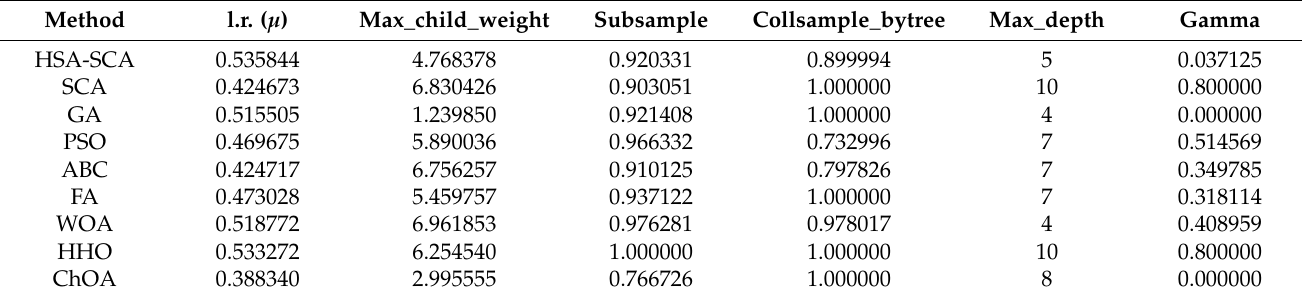
Table 3. Best solutions’ determined XGBoost hyper-parameters